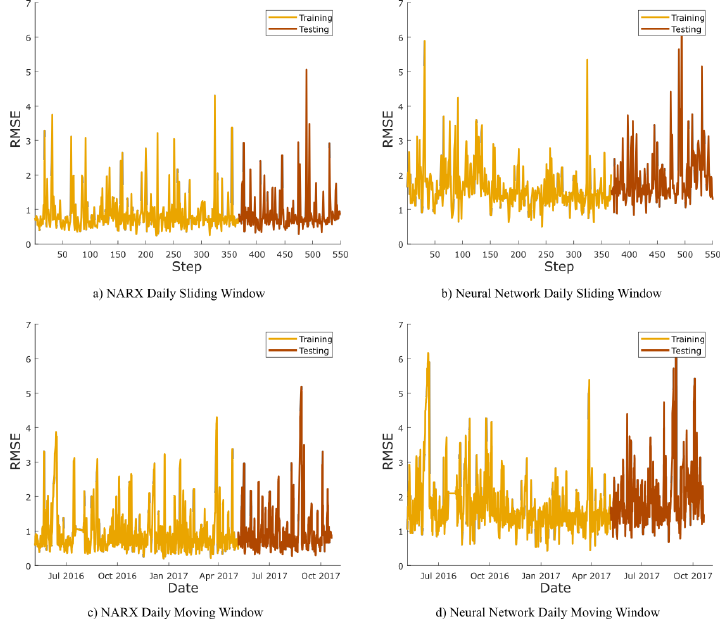
Figure 4. Comparison of daily root mean squared error (RMSE) for NARX vs. Neural Network considering 12 months training period and 10 min mean data